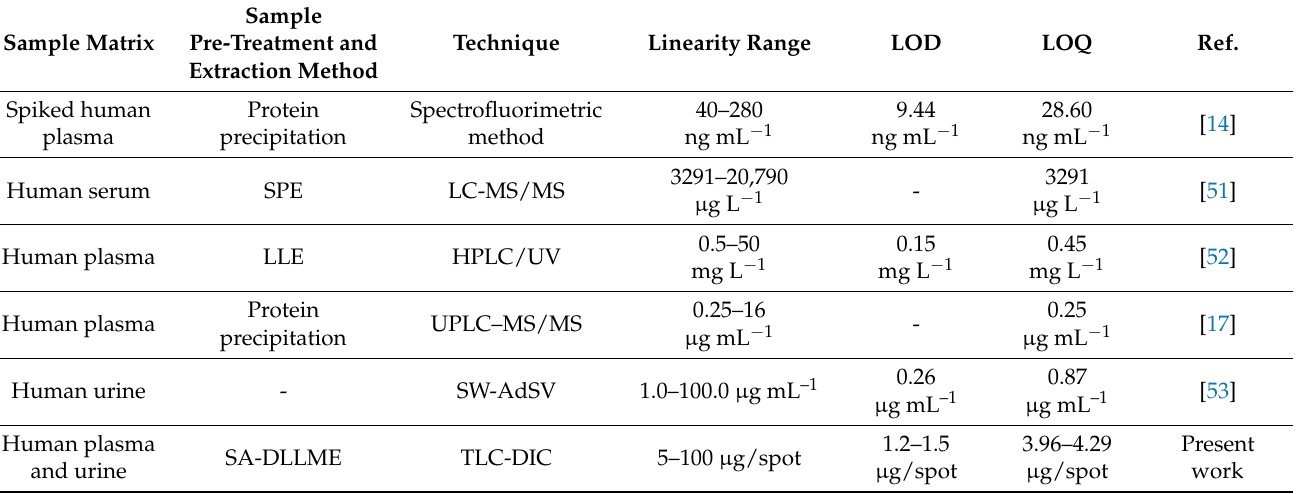
Table 5. Comparison of the proposed method with previously published methods for determining FAV in biological samples.